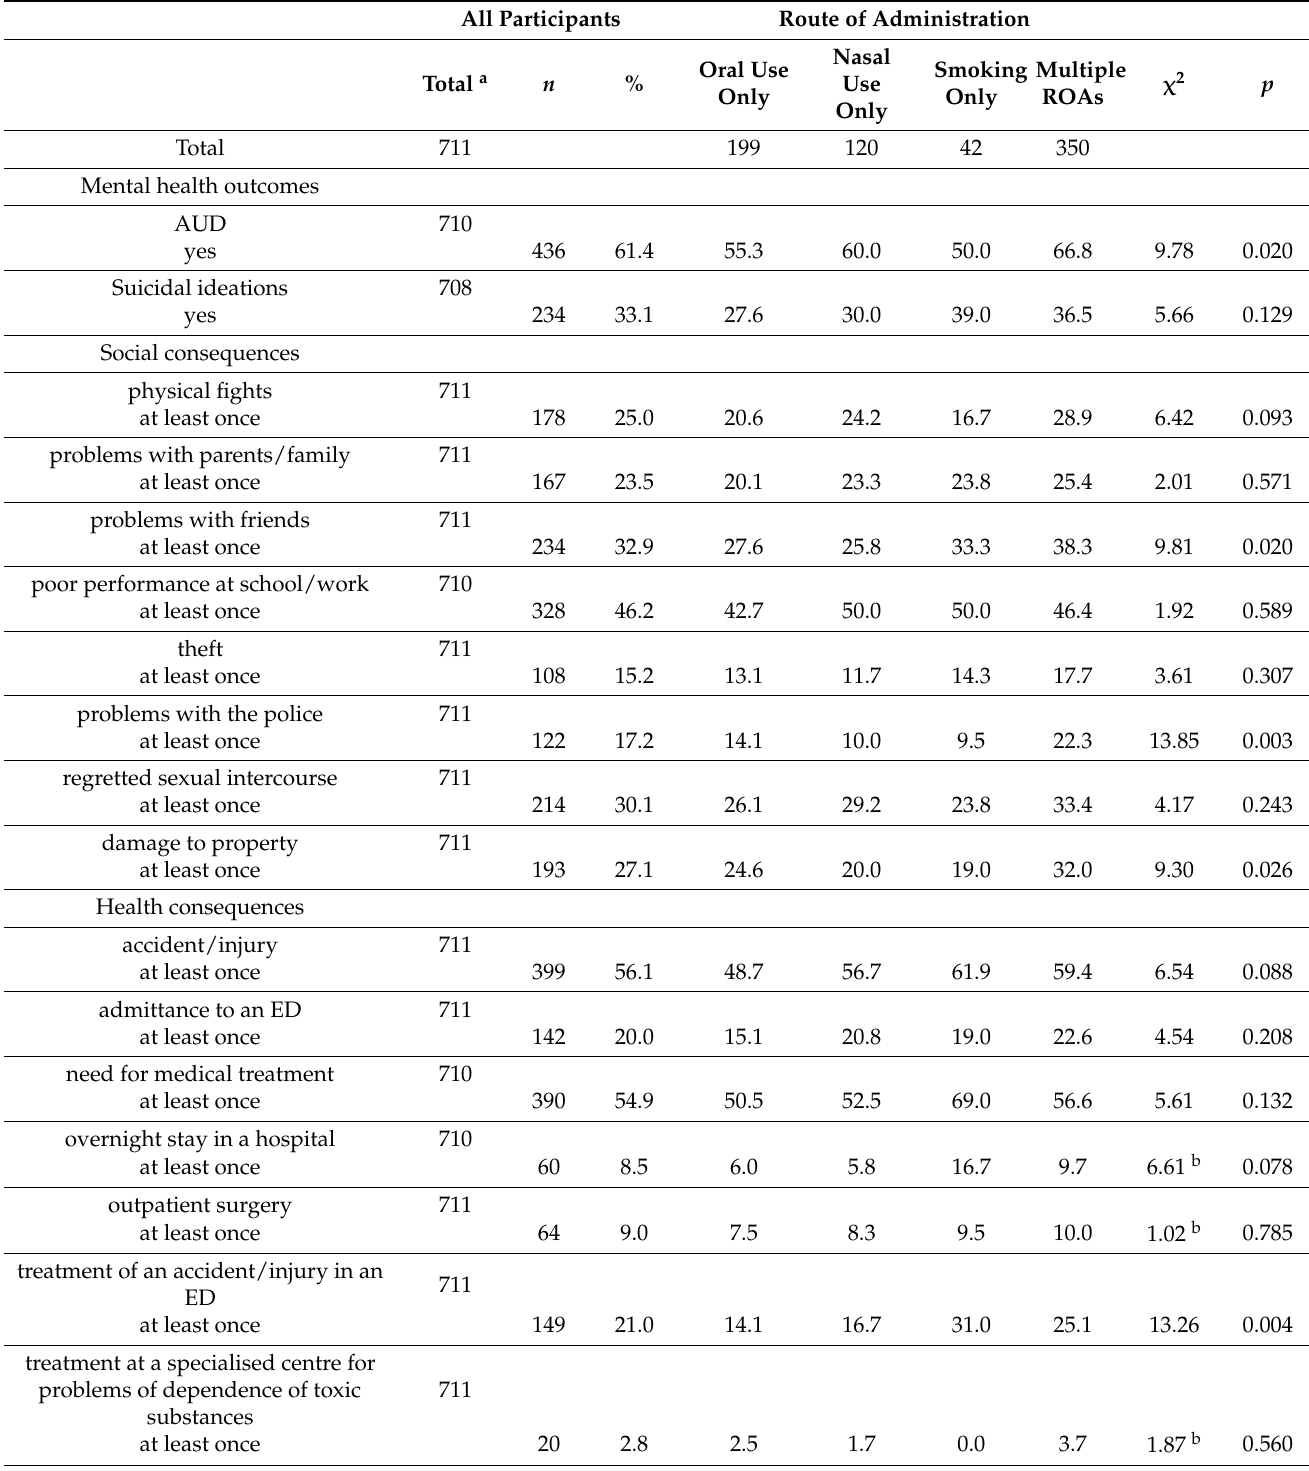
Table 5. Adverse outcomes according to routes of administration among users of any of the 18 illicit drugs.